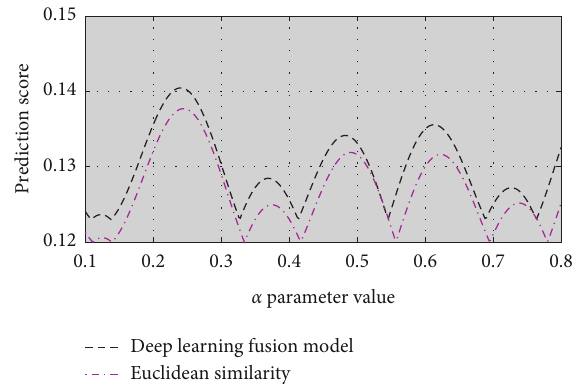
Figure 4: Comparison of prediction score accuracy using Eu- clidean and Pearson’s similarity.